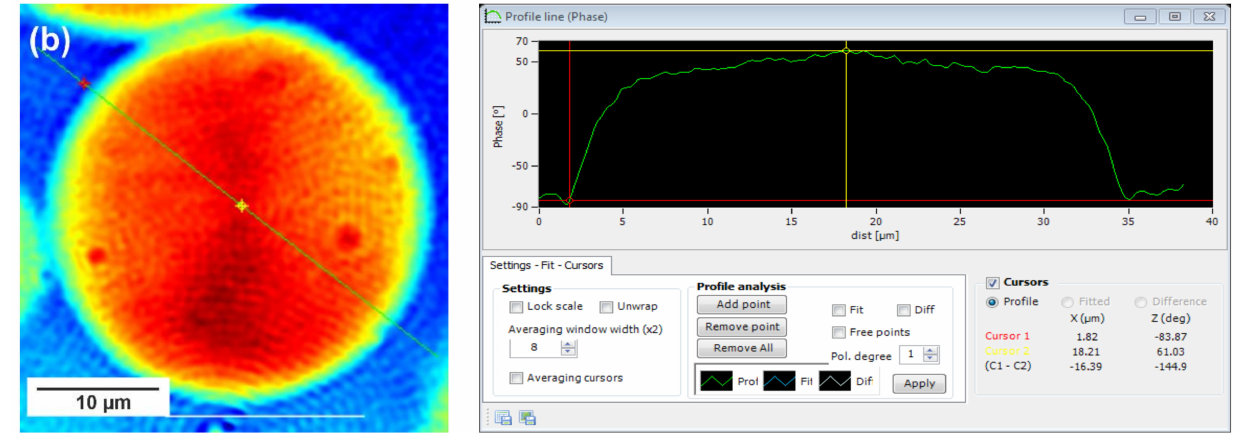
Figure 10. Holographic images and corresponding profiles of the phase changes along the green line recorded for single spherulites crystalized from the melt for ( a ) PBS-DLS 50-50_E and ( b ) PBS-DLS 50-50_M. The DHM microscope magnification is 50 × .